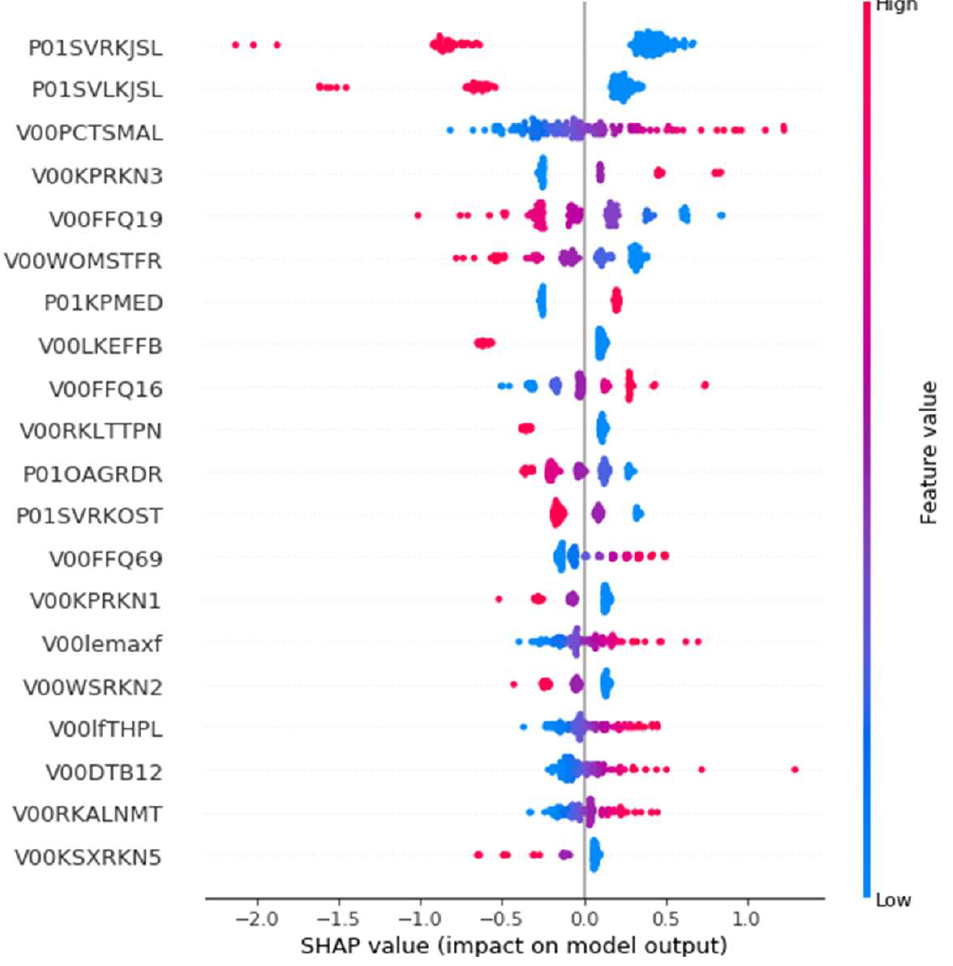
Figure 12. The distribution of the features’ impact on LR model output for the OAI (osteoarthritis initiative) dataset with 29 features across all instances.